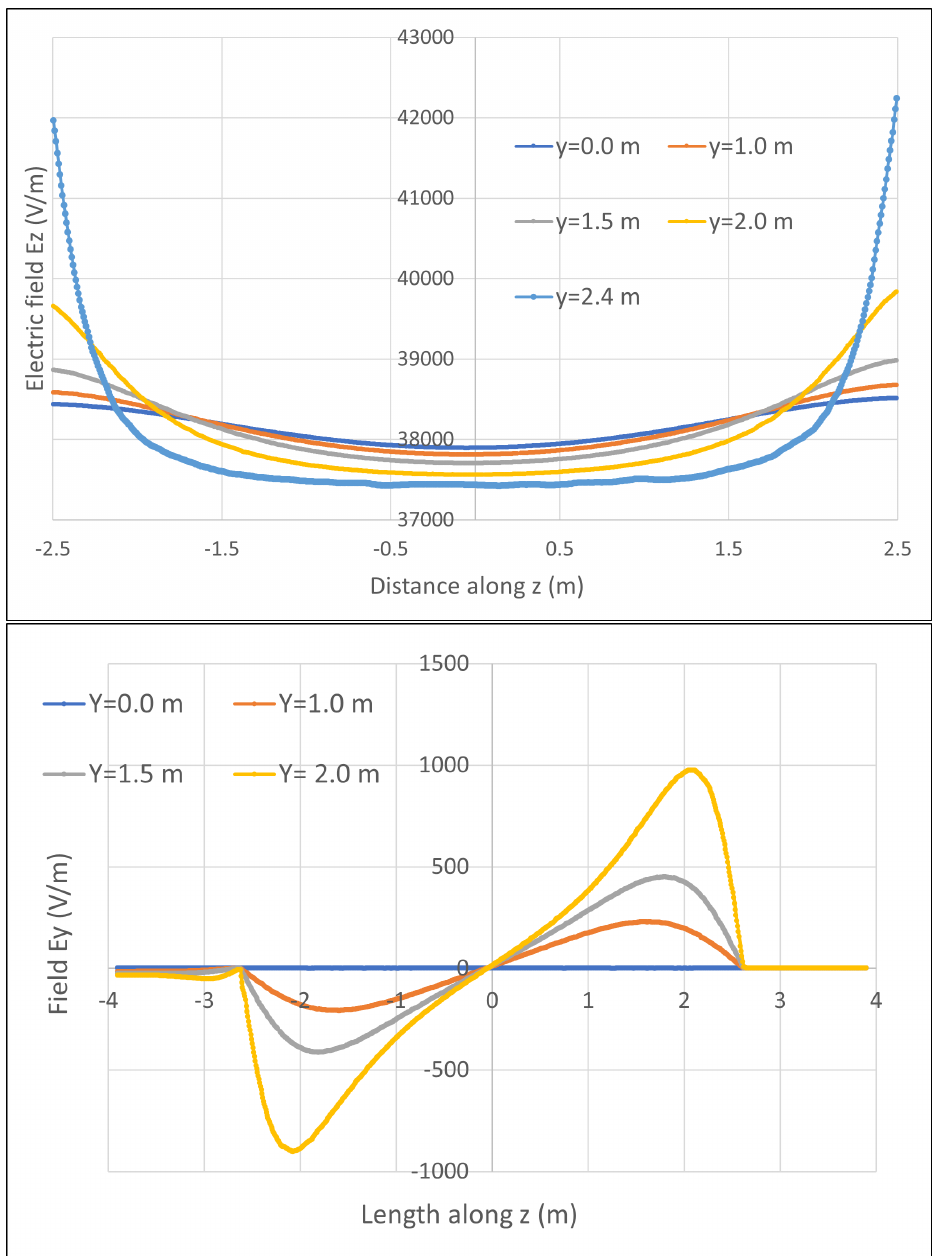
Figure A7. ( Top ): Electric field component E z for the single-anode design. ( Bottom ): Electric field component E y for the single-anode